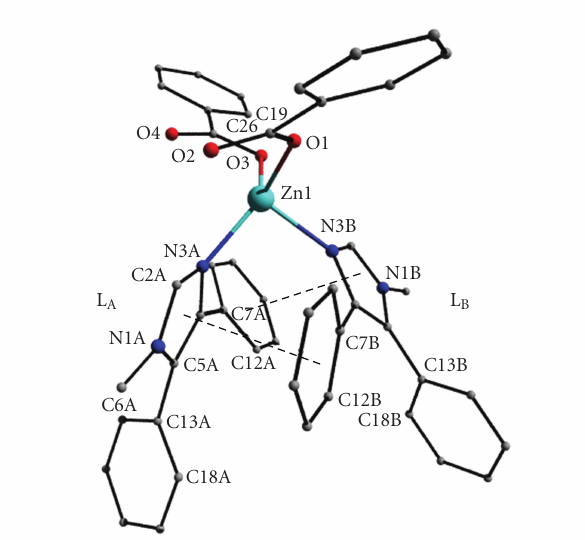
Figure 1: A partially labeled plot of complex 1 · 2MeOH. The methanol molecules and the hydrogen atoms have been omitted for clarity. The intramolecular π - π interactions between the two ligands L A and L B are shown with dashed lines. Ring numeration: